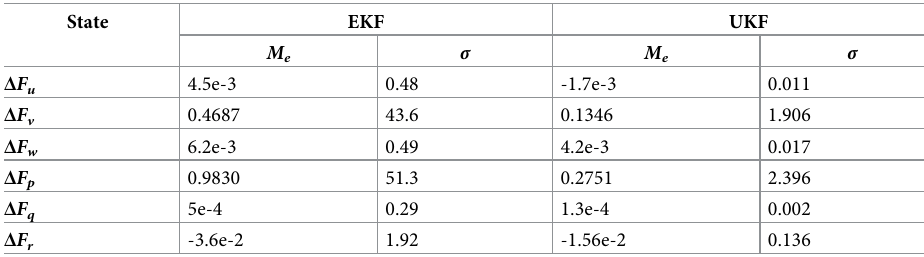
Table 3. Case 1: Mean estimation error for all